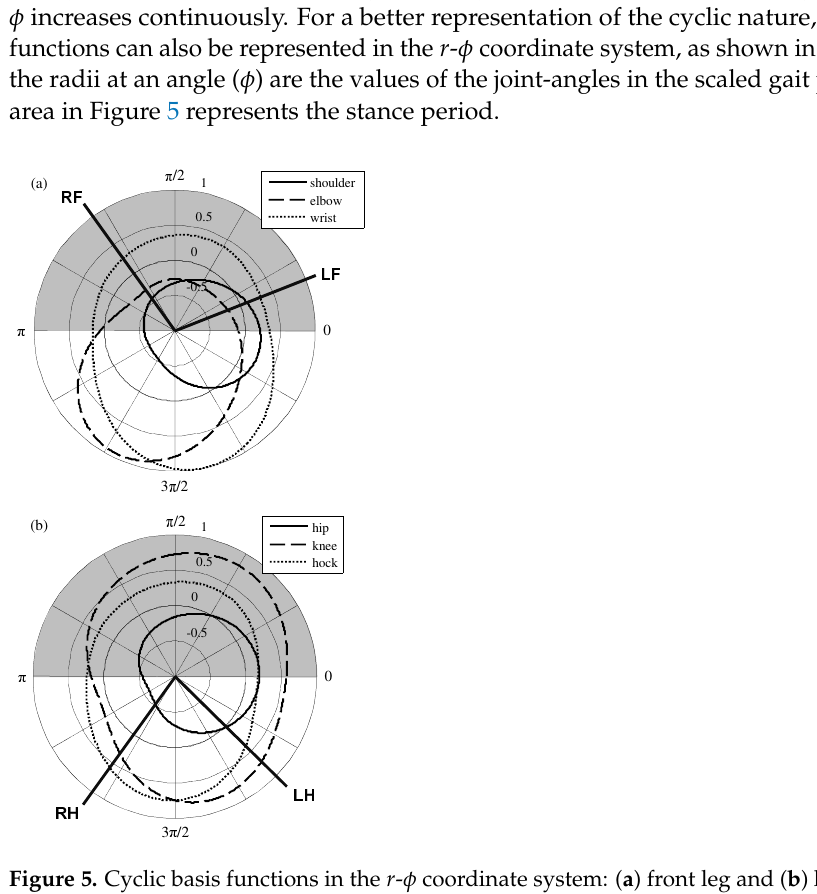
Figure 5. Cyclic basis functions in the r - φ coordinate system: ( a ) front leg and ( b ) hind